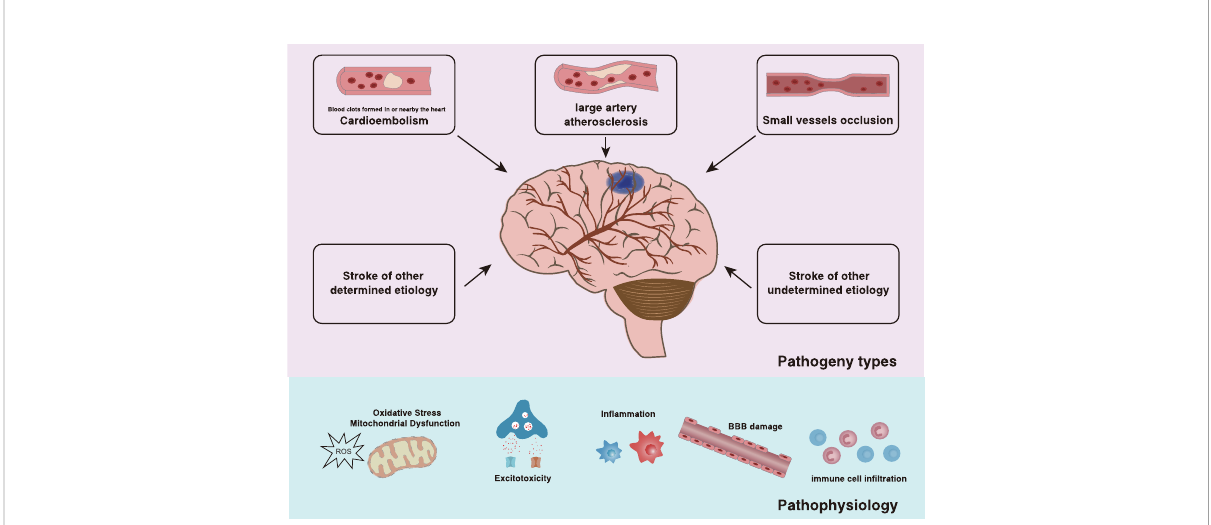
FIGURE 1 Types and effects of IS. According to the TOAST etiology classi fi cation, the etiology of IS is classi fi ed as LAA, CE, SVO, and other determined etiology or undetermined etiology. As the disease progresses, there is a reversible loss of tissue function followed by irreversible neurological de fi cits due to insuf fi cient blood supply to the brain tissue, which is manifested by the ischemic core of irreversibly damaged tissue surrounded by the ischemic penumbra of hypoperfused but potentially salvageable tissue. The pathophysiological processes following IS are complex, involving energy failure, acidosis, loss of cell homeostasis, excitotoxicity, oxidative stress, activation of glial cells, in fl ammation, and disruption of the blood-brain barrier with in fi ltration of